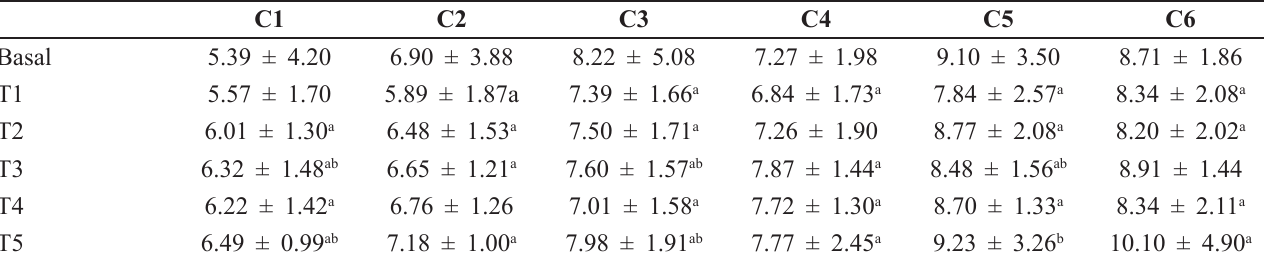
TABLE V - TEWL values (g/mm 2 .h) measured before and 1, 2, 3, 4 and 5 hours after topical application of formulations